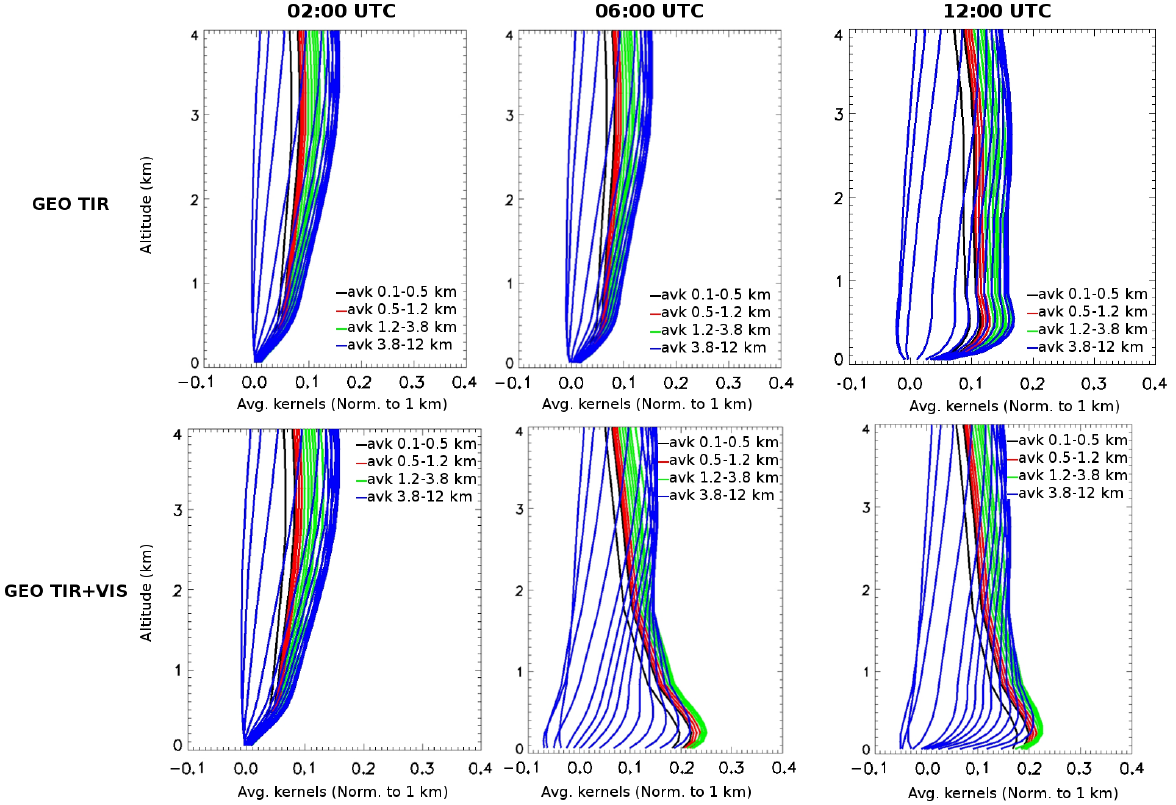
Figure 3. Mean averaging kernels (normalized to 1km), over the red square domain (over both land and sea pixels) in Fig. 2, as a function of altitude (km) at 02:00, 06:00 and 12:00UTC for GEO TIR (top panels) and GEO TIR + VIS (bottom panels). Black curves indicate the surface to 0.5km averaging kernels, red curves indicate the 0.5 to 1.2km averaging kernels, the green curves indicate the 1.2 to 3.8km averaging kernels, and the blue curves indicate the 3.8 to 12km averaging